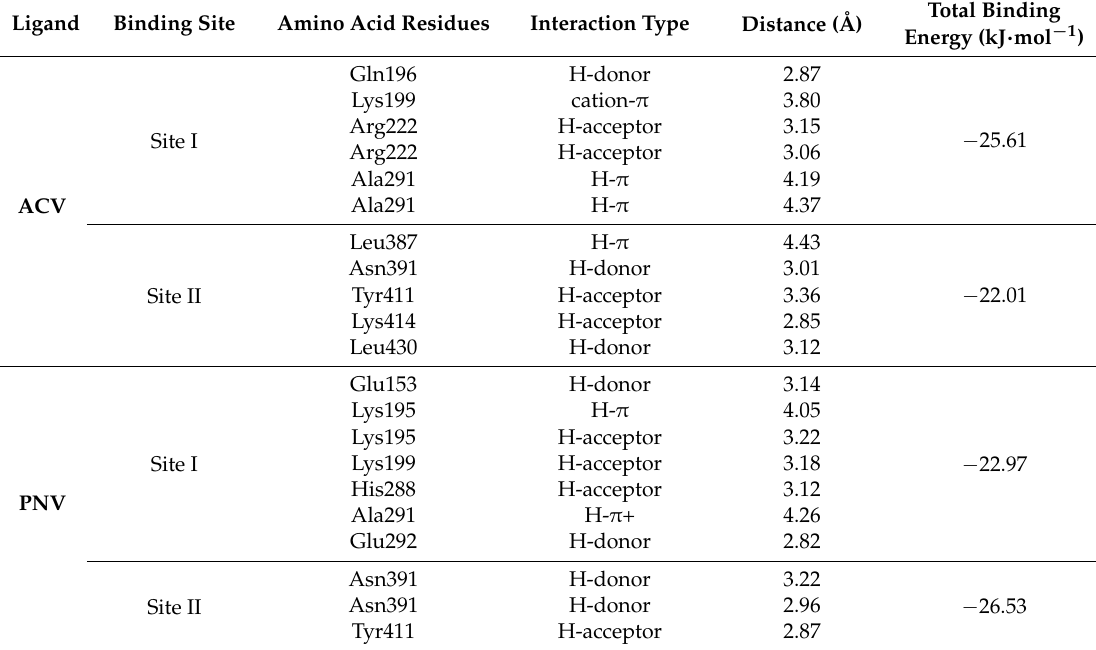
Table 5. Molecular simulation results for ACV/PNV interactions with